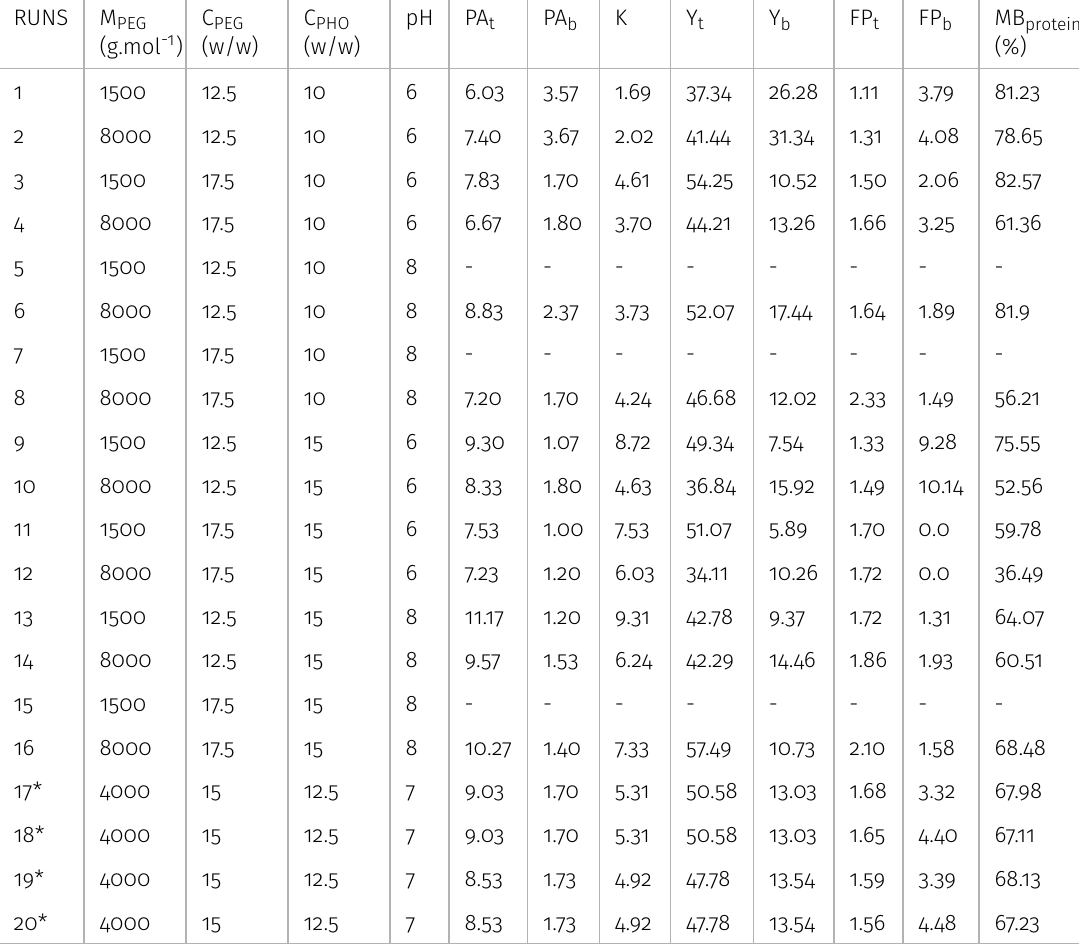
Table III. Production of fibrinolytic enzyme by Streptomyces parvulus DPUA 1573 using different substrates in liquid